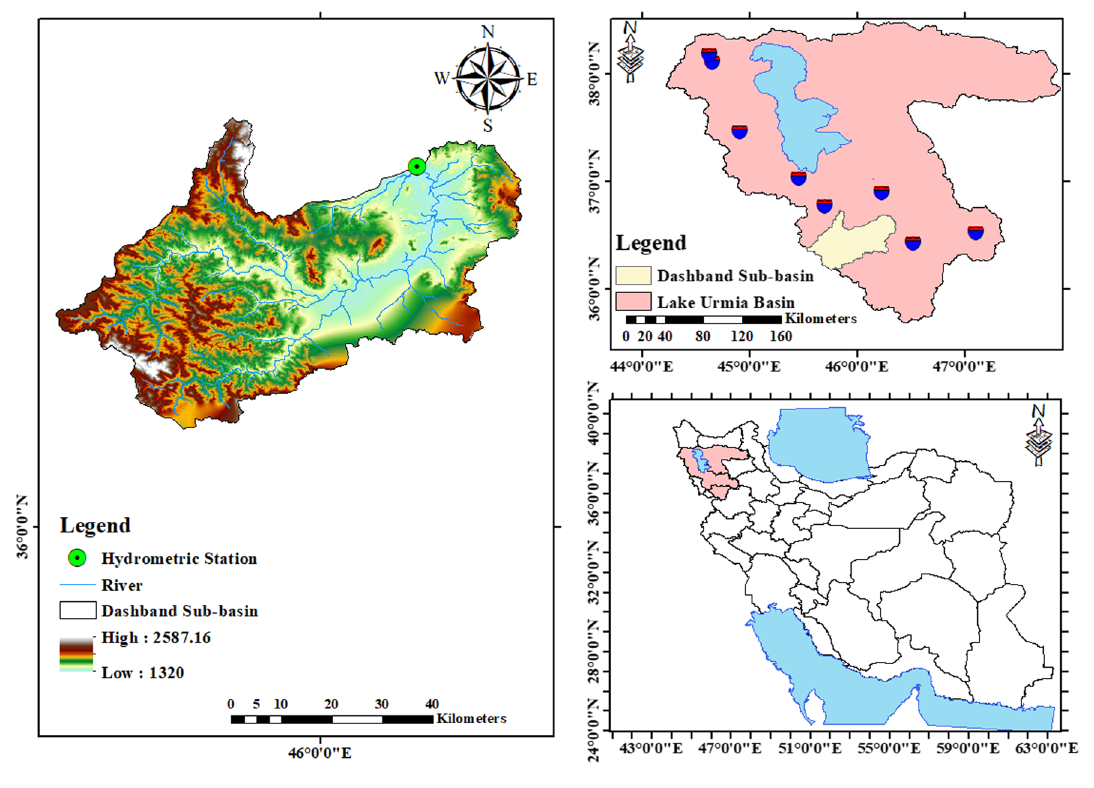
Fig. 1 Location map of Dashband sub-basin in Lake Urmia basin, Iran Table 1 Summary statistic of the studied data in 1970–2018 Variable Minimum Maximum Mean Std. deviation AMD (m 3